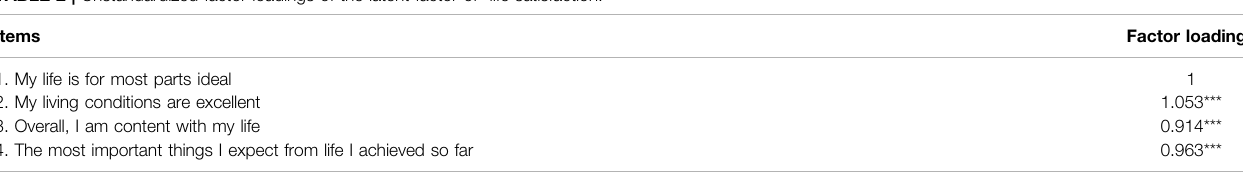
TABLE 2 | Unstandardized factor loadings of the latent factor of “ life satisfaction. ”